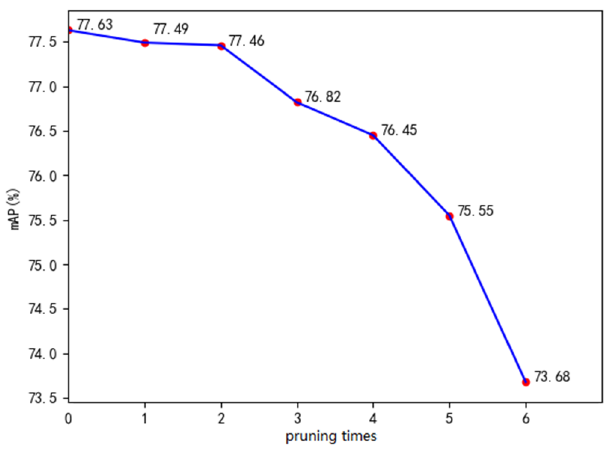
Figure 7. The mAP with 6 prunings.